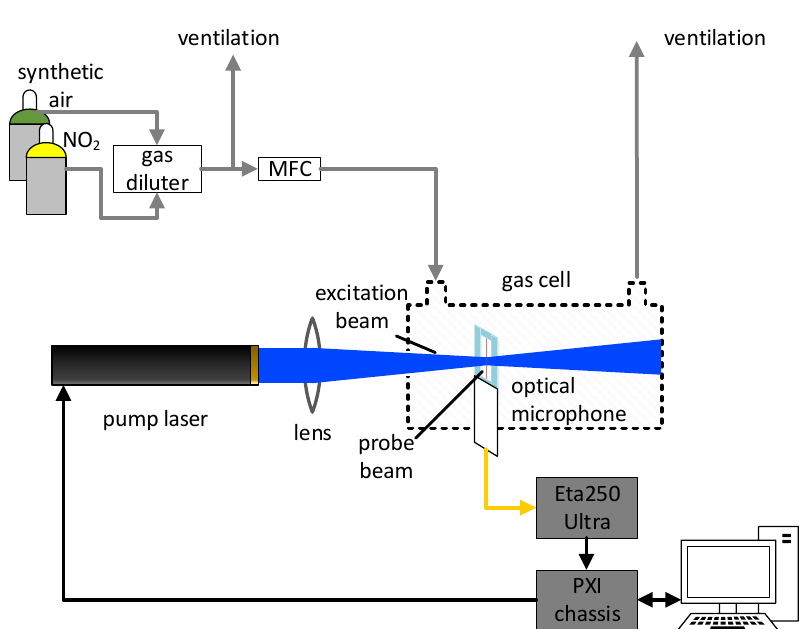
Figure 2. Schematic of the experimental setup for characterizing the photothermal interferometry setup with NO 2 . Gas mixtures are created with a gas diluter. The excitation beam is perpendicular to the probe beam and is focused and centered into the cavity of the optical